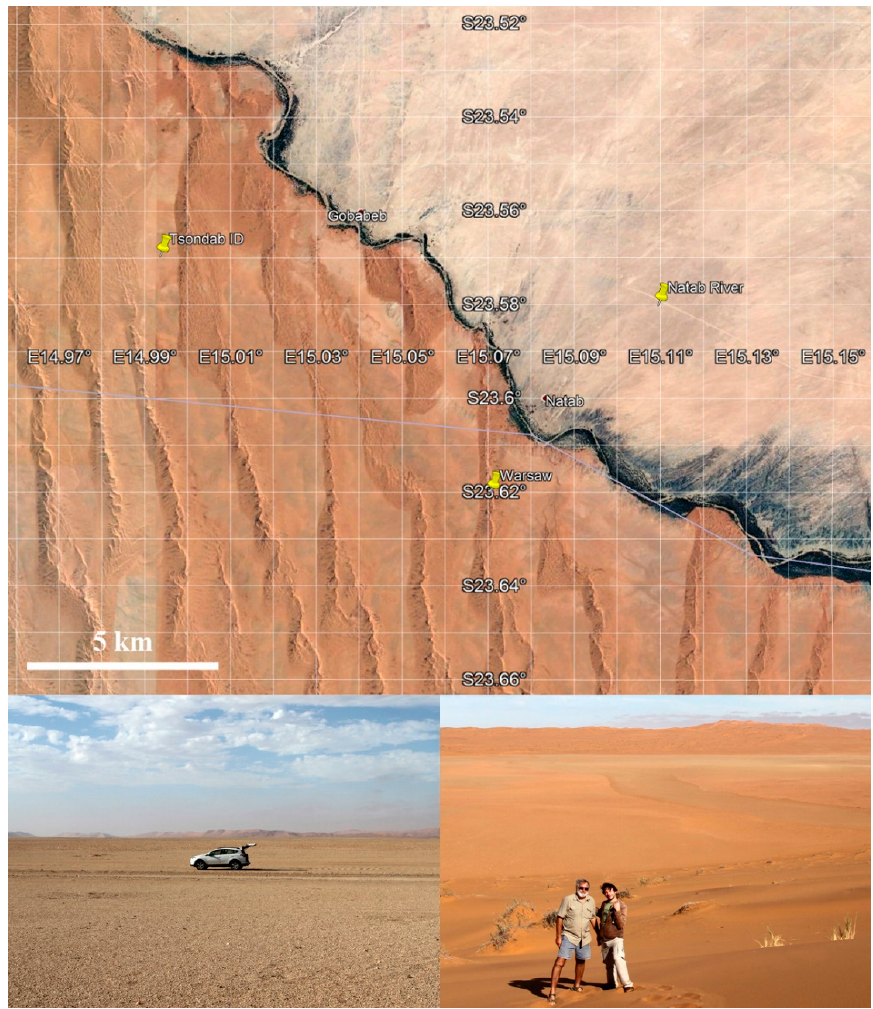
Figure 1. ( Top ): The Kuiseb River close to the Gobabeb Research Center, marking the limit between the southern dunes of the Namib Sand Sea and the northern desert plain. The three study sites are indicated: Tsondab ID, Natab River and Warsaw dune. ( Bottom left ): view of the northern rock plain close to Natab River site (23.58 ◦ S / 15.11 ◦ E). ( Bottom right ): view of the interdune valley close to the Tsondab ID site (23.57 ◦ S / 14.99 ◦